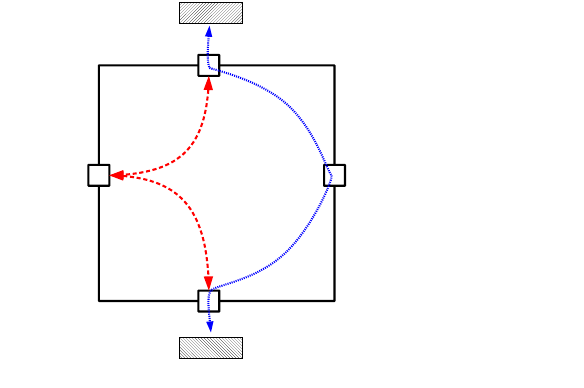
Figure 1. IEC 62351 end-to-end security (short dashed line) and 802.1AE point-to-point security (long dashed